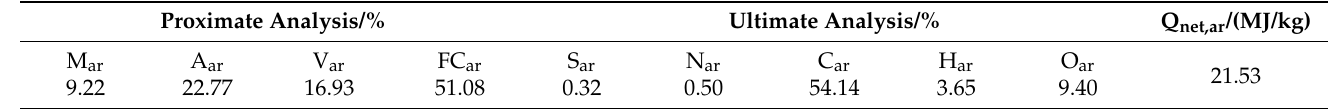
Table 1. Proximate and ultimate analyses of the coal.